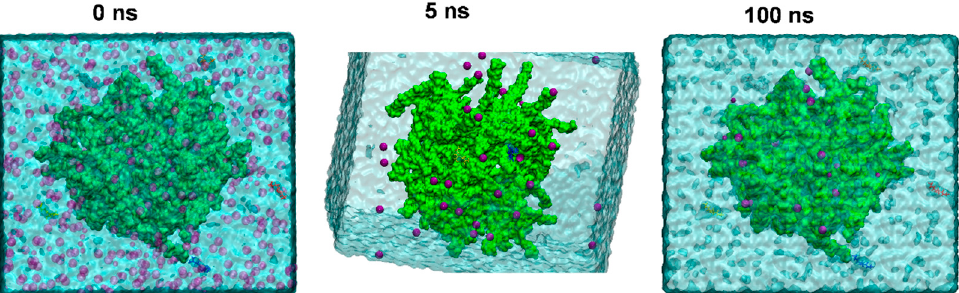
Figure 6. Molecular dynamic simulation of an alginate sphere structure in a water box in the presence of GSH and CaCl 2 . GSH molecules were represented in different colors, and purple dots correspond to CaCl 2 . Left to right images represent different times of the MD simulation. The center image was rotated 15 ◦ on the X axis and 20 ◦ on the Y axis in order to better observe the GSH inside the alginate sphere.